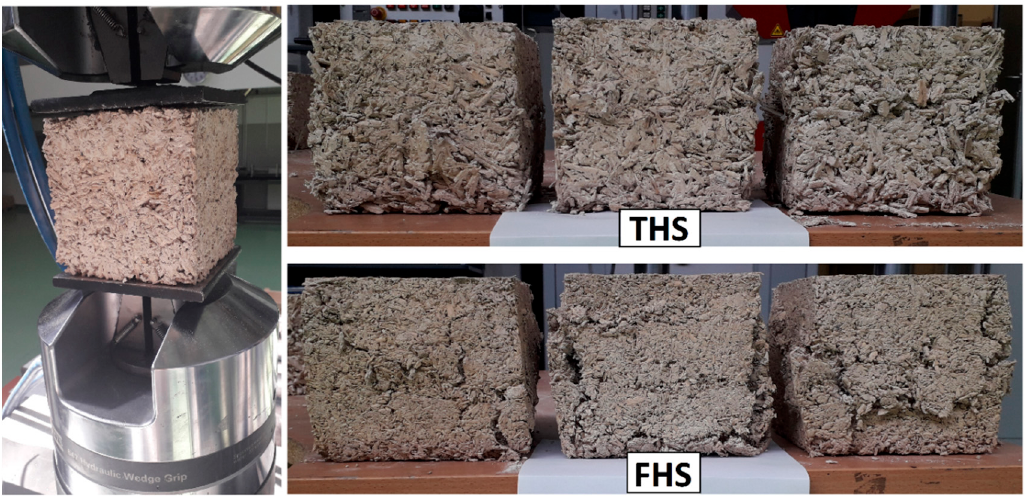
Figure 7. The compressive strength test set-up and the forms of destruction of composite specimens from THS and FHS mixtures.